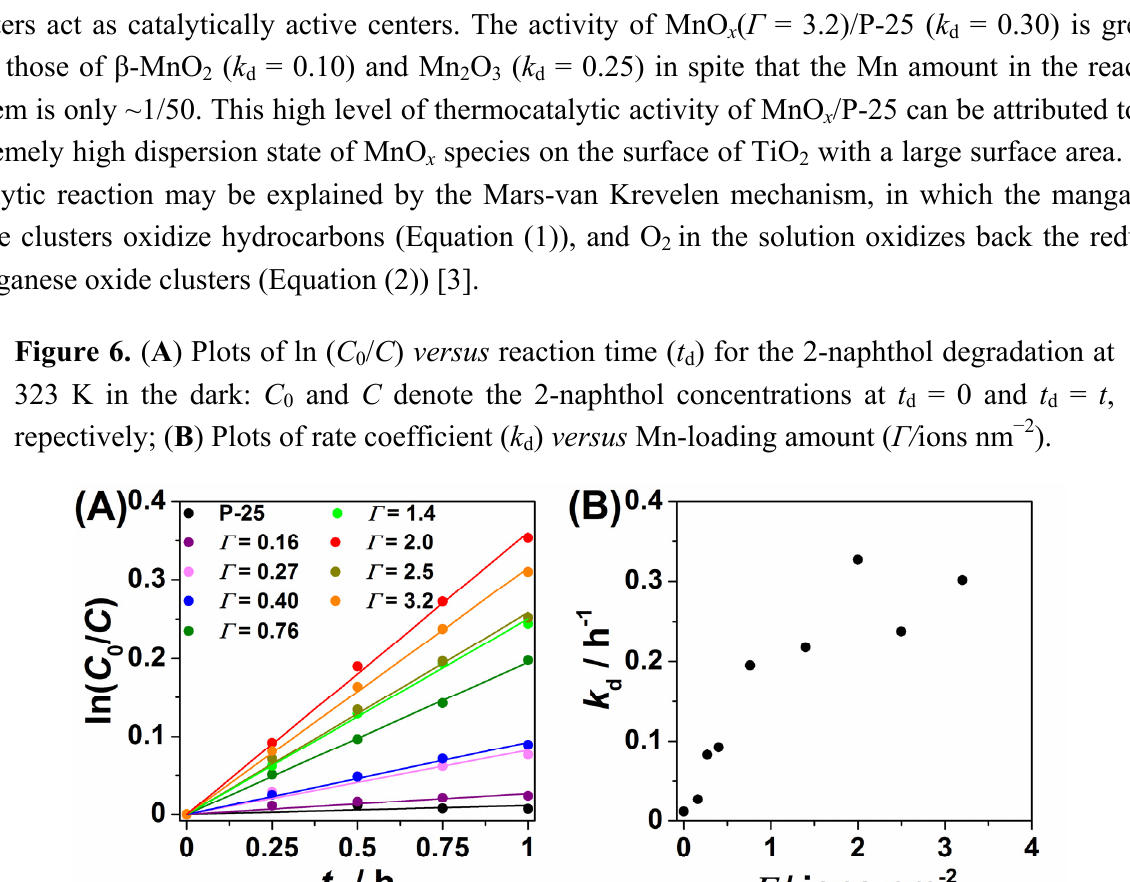
and C denote the 2-naphthol 0